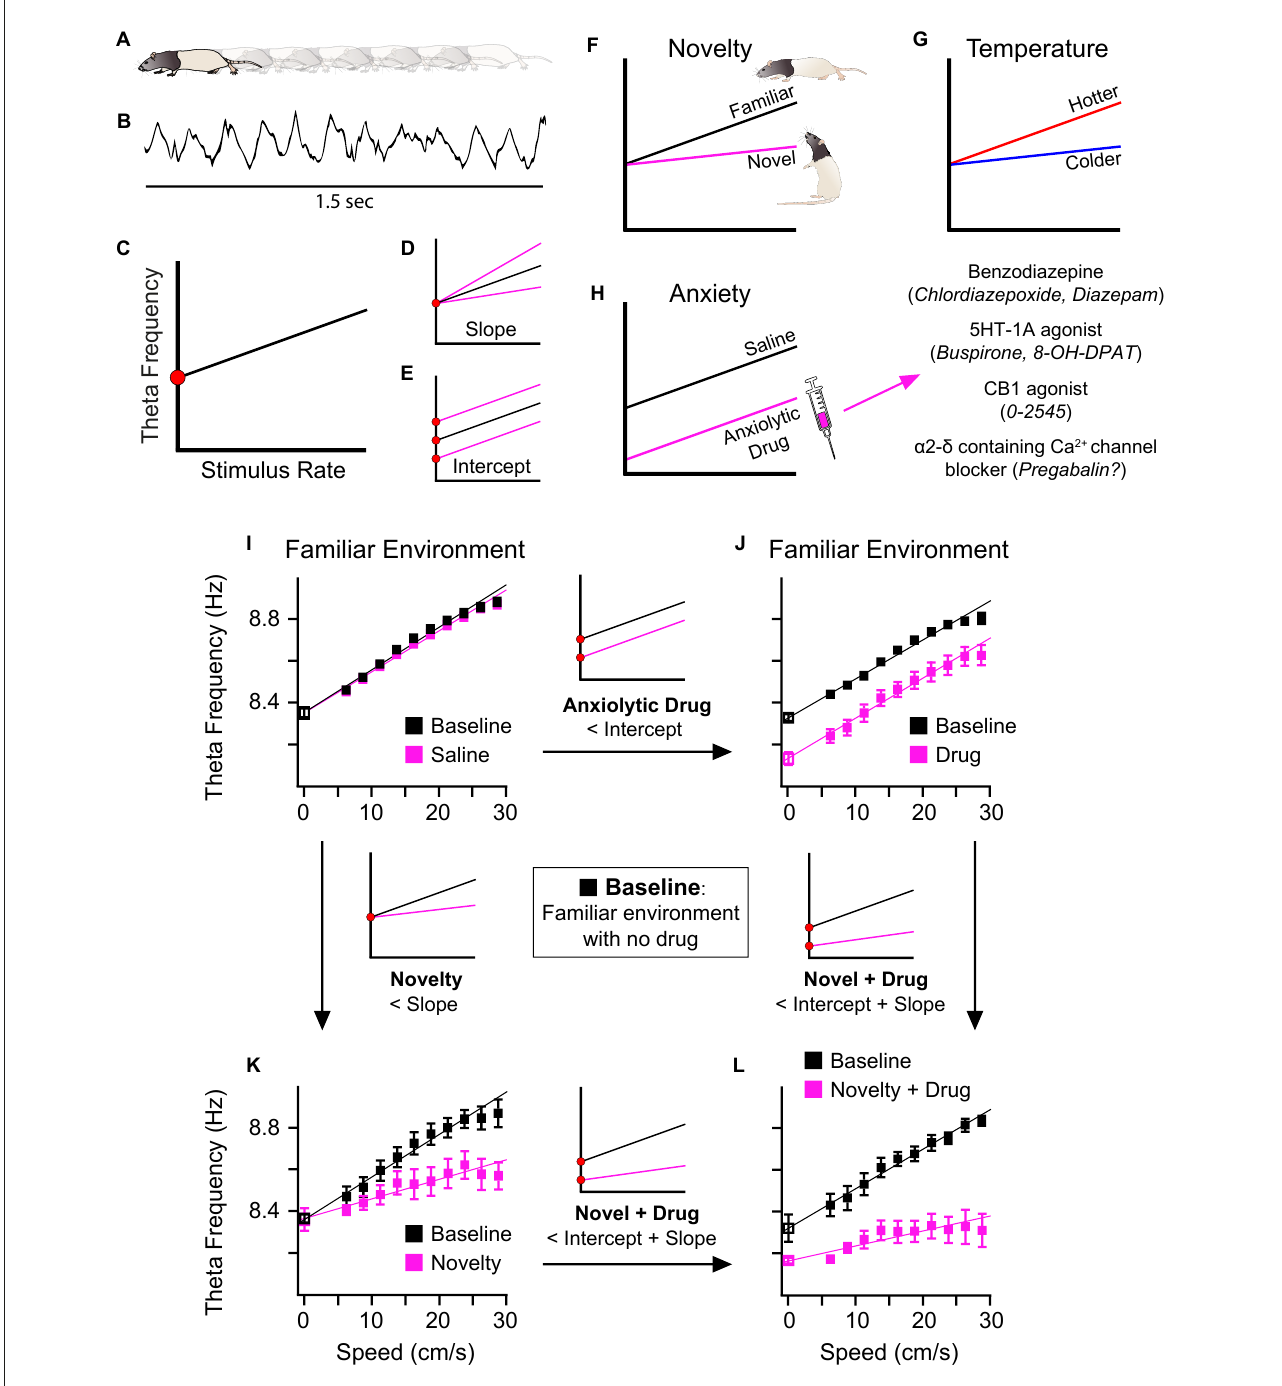
FIGURE1 Schematic diagram. Two components of theta frequency and their functional associations. As rats locomote (A) during a foraging task, hippocampal formation theta is recorded (B) . Taking running speed in such locomotion as a model of stimulus rate, a positive correlation is reliably observed (C) between theta frequency (y-axis) and stimulus rate (x-axis). Instantaneous theta frequency is modelled, based on Burgess (2008), as sum of two frequency components: (1) the gain in theta frequency as stimulus rate increases, here called “theta slope” (D) ; and (2) the “baseline” frequency or y-intercept at zero stimulus rate, here called “theta intercept” (E) . Changes in theta slope and theta intercept are doubly dissociable and have different functional associations. Novelty flattens, and familiarity increases, theta slope (F) . Temperature positively correlates with theta slope (G) . Systemic injection of different classes of anxiolytic drug has a common effect of reducing theta intercept (H) . Real data showing double dissociation in effects of novelty and anxiolytic drug upon theta slope and intercept shown in (I–L) . In a familiar environment, saline injection has no effect on theta slope for intercept (I) , but following injection of an anxiolytic drug, theta intercept is selectively reduced (J) . In a novel environment (saline injection as control), theta slope is selectively reduced (K) . In a novel environment, following injection of anxiolytic drug, both theta slope and intercept are reduced (L) . Parts (F–H) schematically summarise data from: dorsal hippocampal theta (Wells et al., 2013; Newman et al., 2013), see Sections “3 Results regarding novelty-familiarity dimension” and “4 The anxiolytic drug pregabalin selectively reduced theta intercept” of the present article; medial entorhinal theta (Monaghan et al., 2017). Parts (I–L) adapted from Figure 6 of Wells et al.